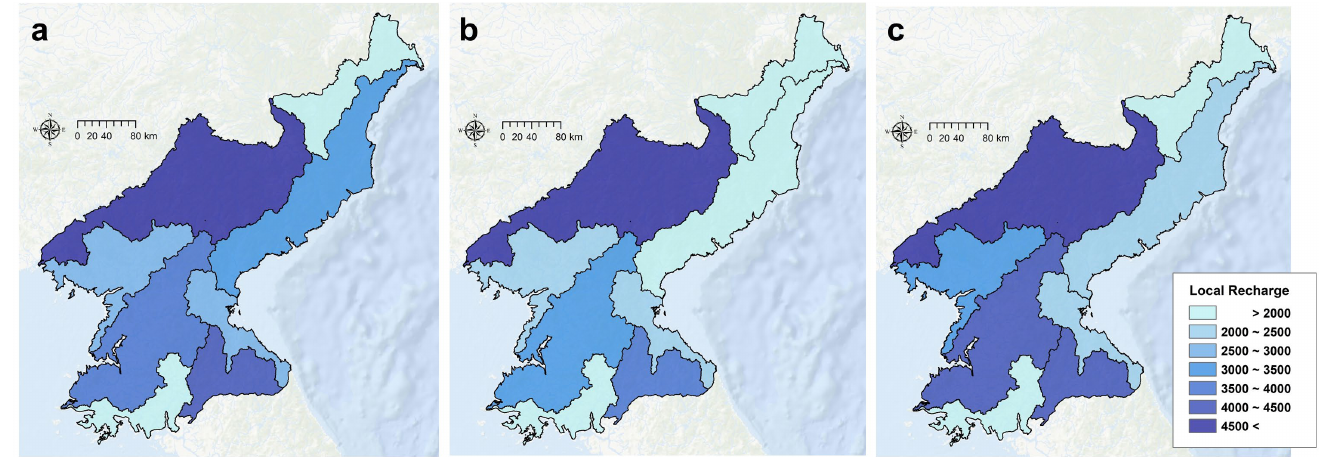
Figure 6. Local recharge amount at the main watershed level: ( a ) baseline period (1981–2010), ( b ) climate change (2041–2070), and ( c ) climate and afforestation scenario (Level 3, 2041–2070).